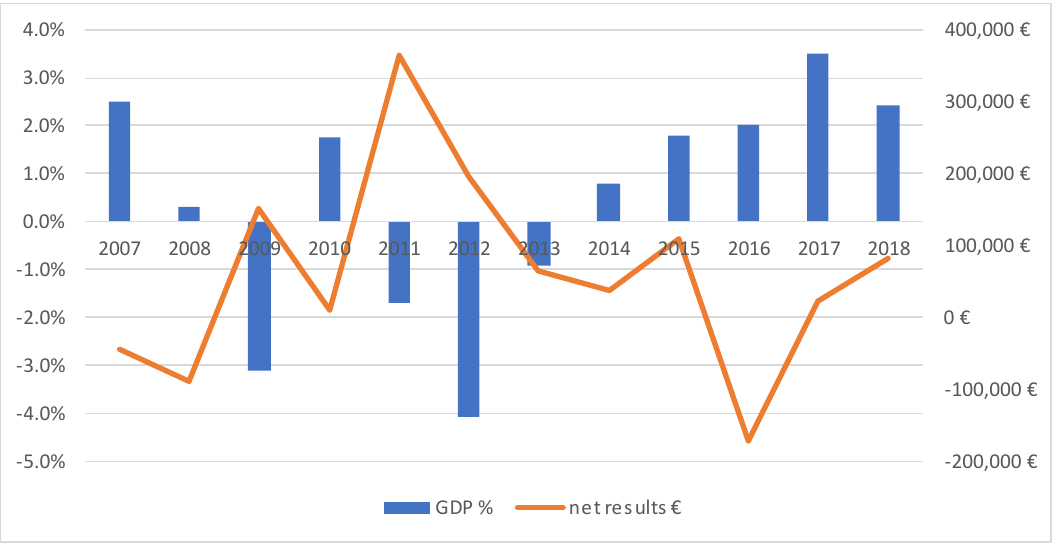
Figure 2. Portuguese GDP growth and CML’s net results (2007 – 2018).